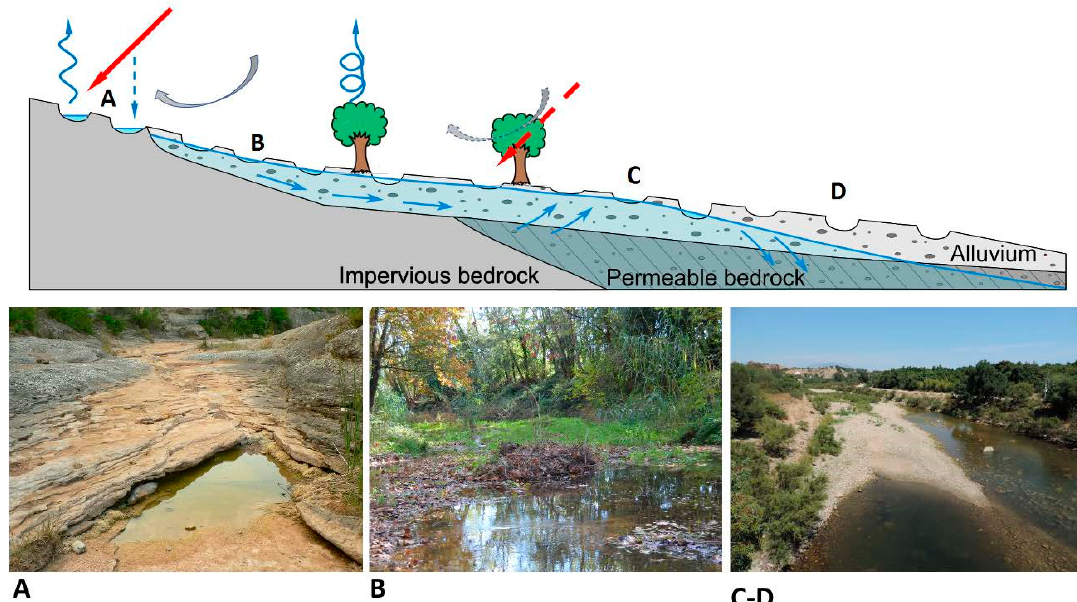
Figure 2. Schematic situation of isolated pools and their relationships with groundwater. ( A ): “perched” pools. ( B ): “through-flow” pools. ( C ): “groundwater gaining” pools. ( D ): “groundwater losing” pools. Blue arrows correspond to water (subsurface water, precipitation, evaporation, and transpiration). Red arrows correspond to direct or intercepted solar radiation. Grey arrows correspond to direct or intercepted wind. Modified from References [15,31]. Photo credits: FEHM- Lab.